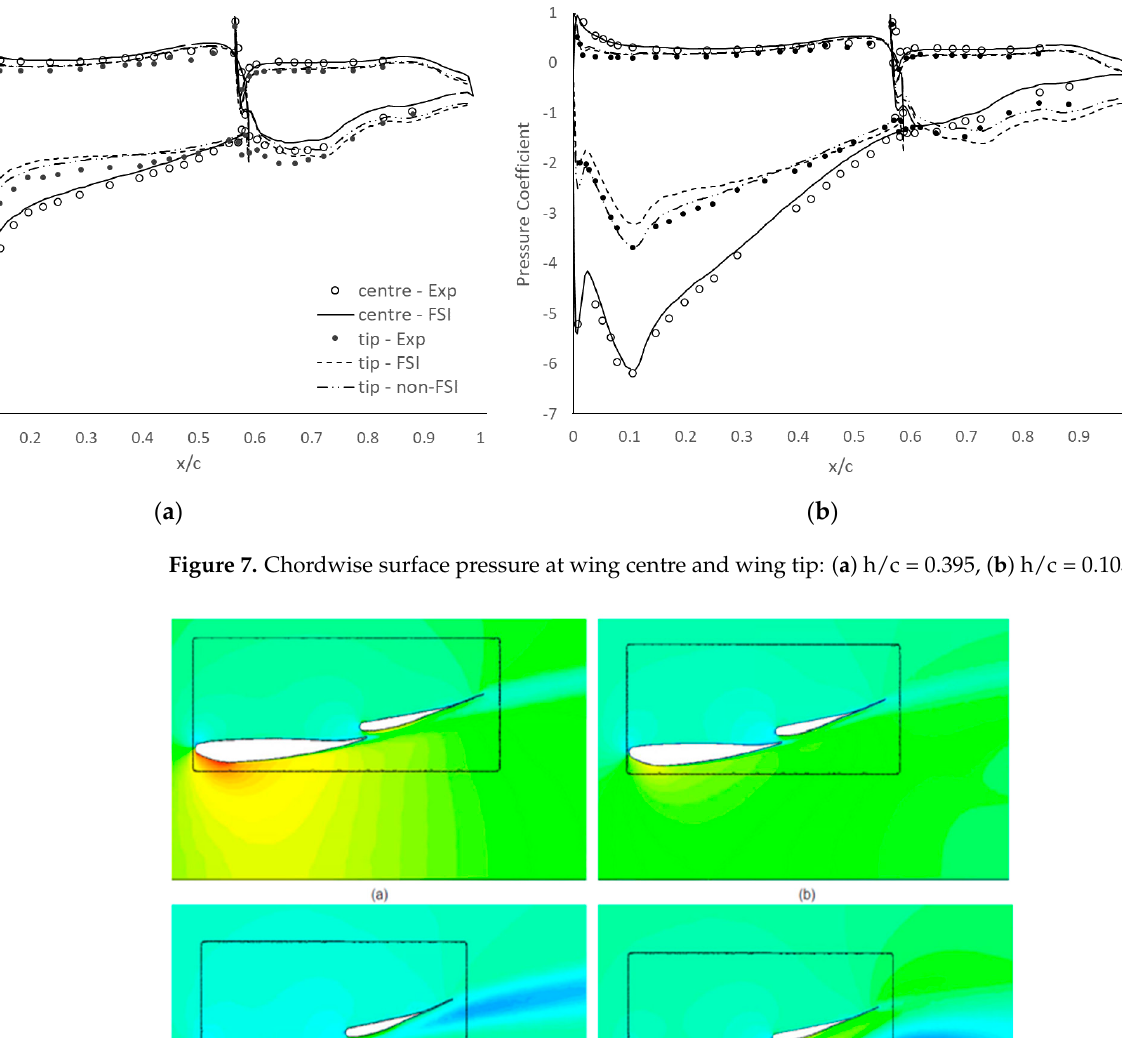
Figure 6. Chordwise surface pressure at wing centre: ( a ) high ride heights, ( b ) low ride heights.